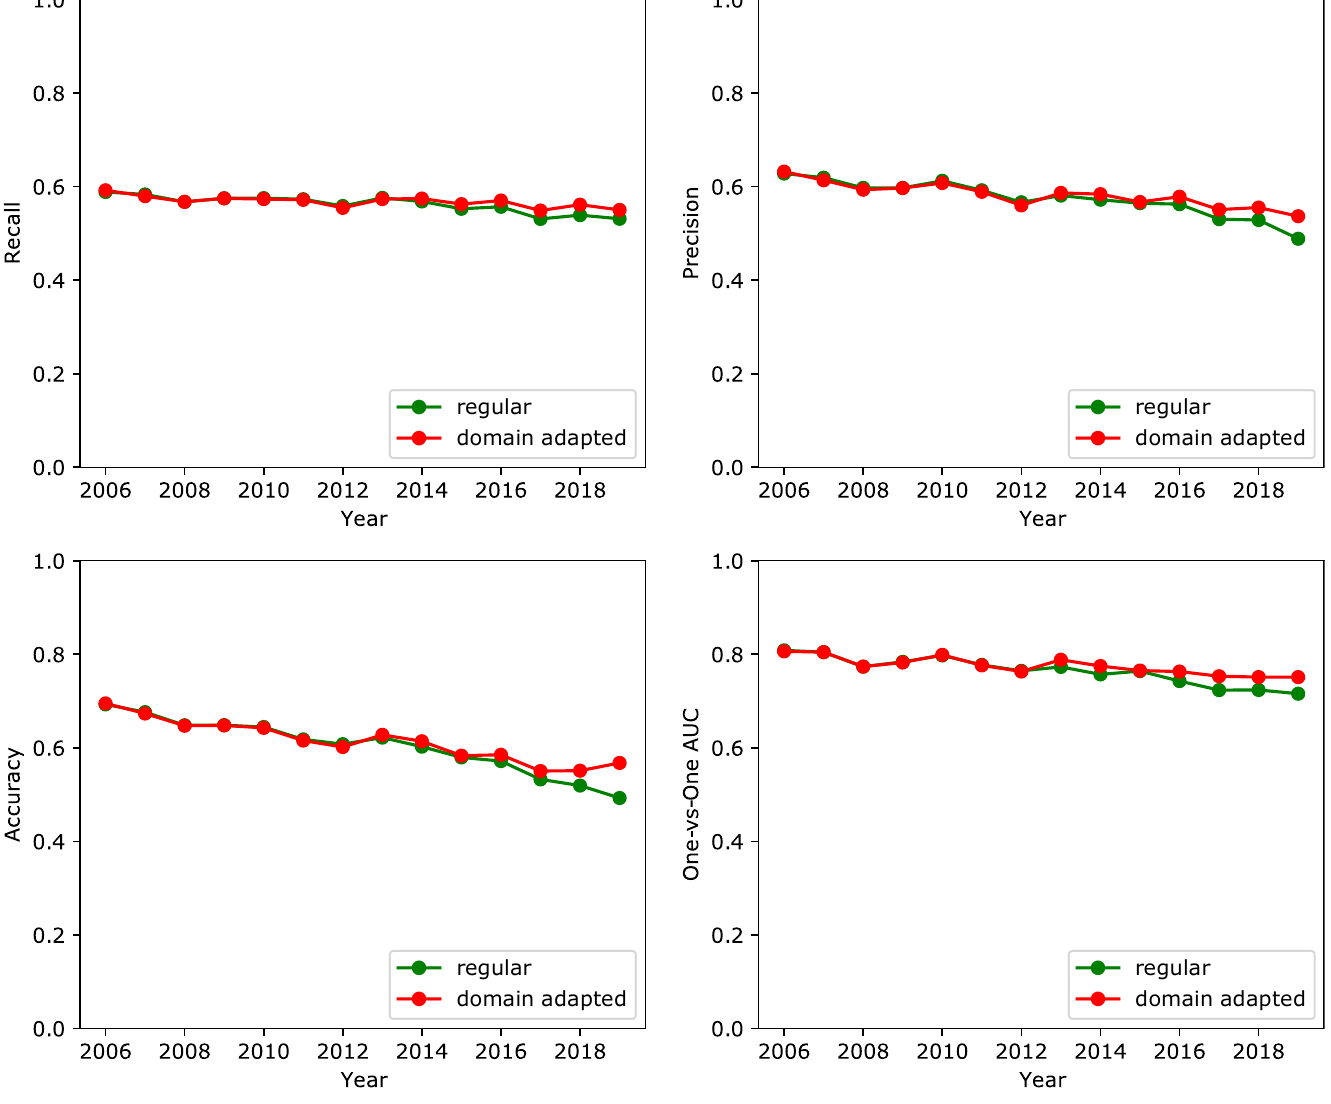
Fig 5. Predictive performance of random forest models with and without domain adaptation on dataset with reduced MeSH features.